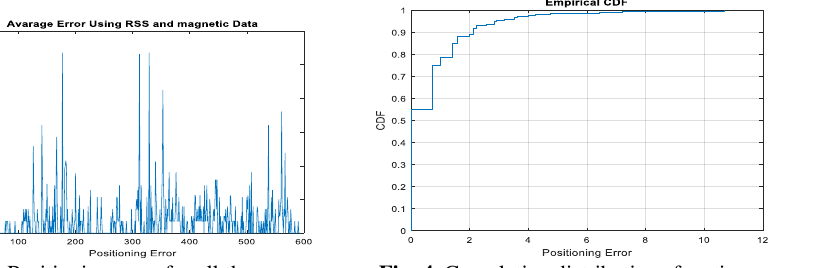
Fig. 4 . Cumulative distributions function of the positioning error when both Magnetometer and RSS is used] measurements is used